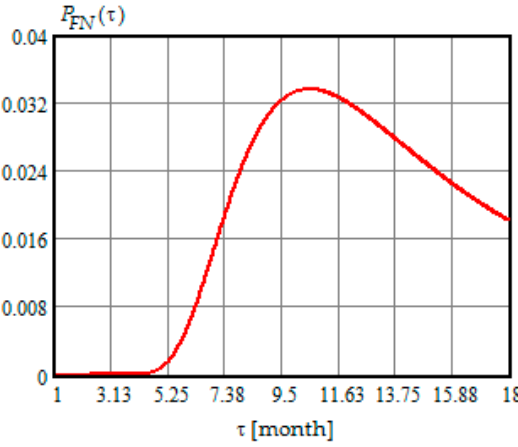
Figure 7. The dependence of the probability of true positive on the length of the interval τ .